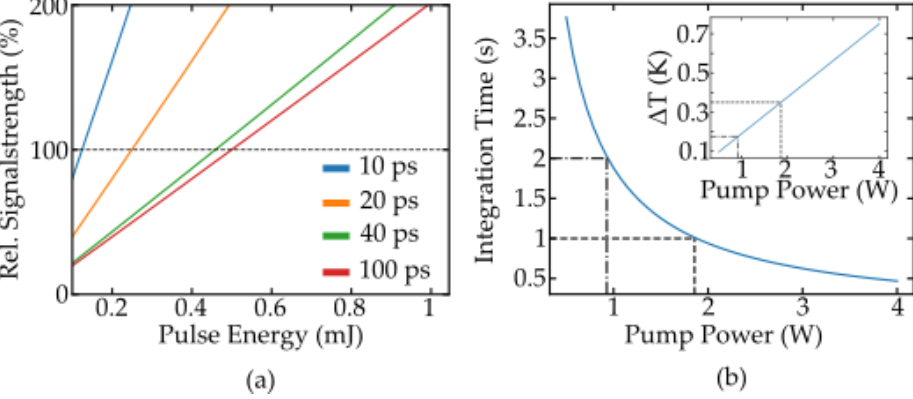
Figure 6. Requirements for pulse energy ( a ) and pumping power ( b ) to maintain the signal strength of the 3.9ns excitation marked in Figure 5 and the temperature deviation caused by laser absorption (inset